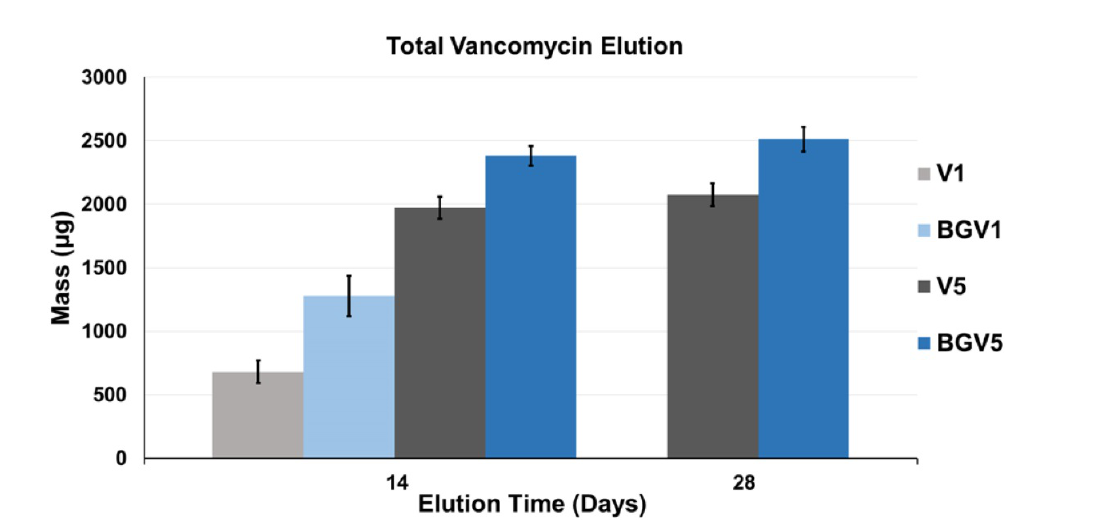
Figure 3. Average total elution of vancomycin over 14 days for all groups, and 28 days for V5 and BGV5. Error bars indicate ± one standard deviation from the mean (n=10).